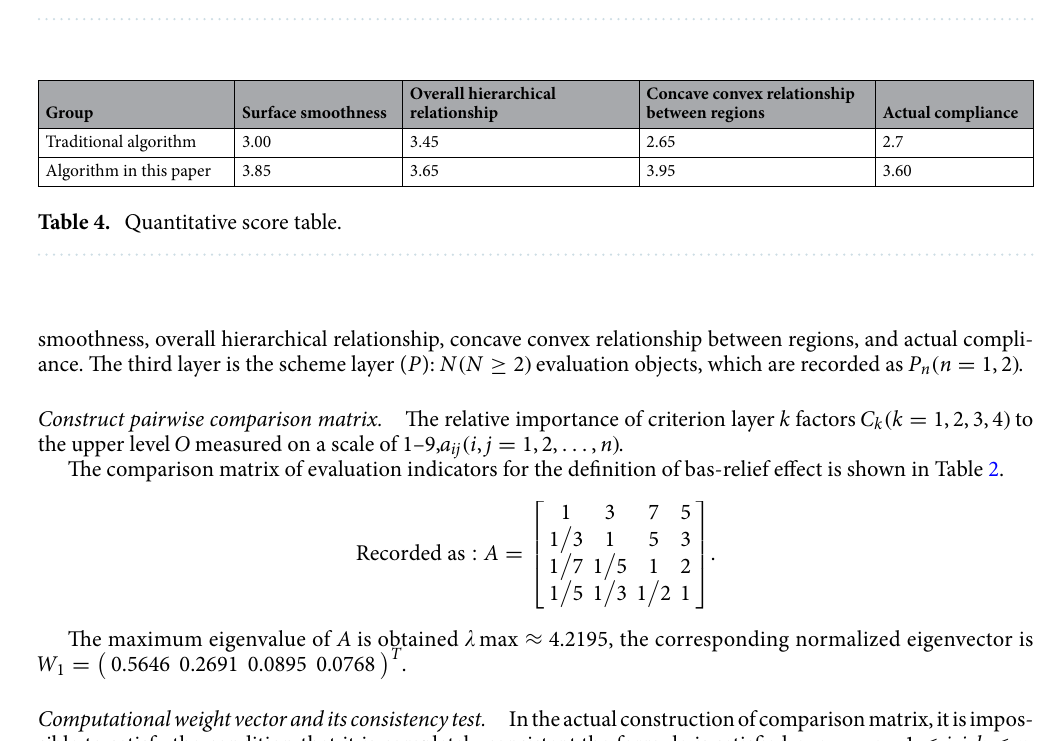
Table 3. Standard value of average random consistency index.